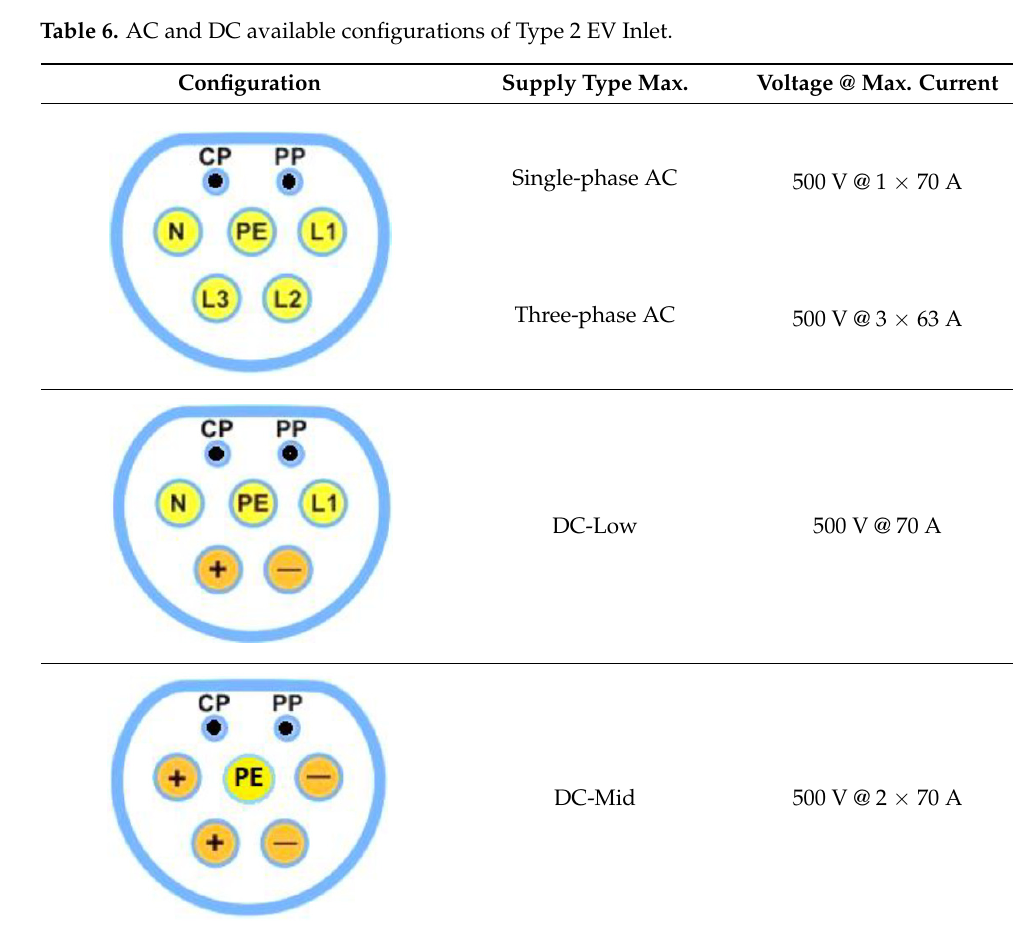
Table 6. AC and DC available configurations of Type 2 EV Inlet.